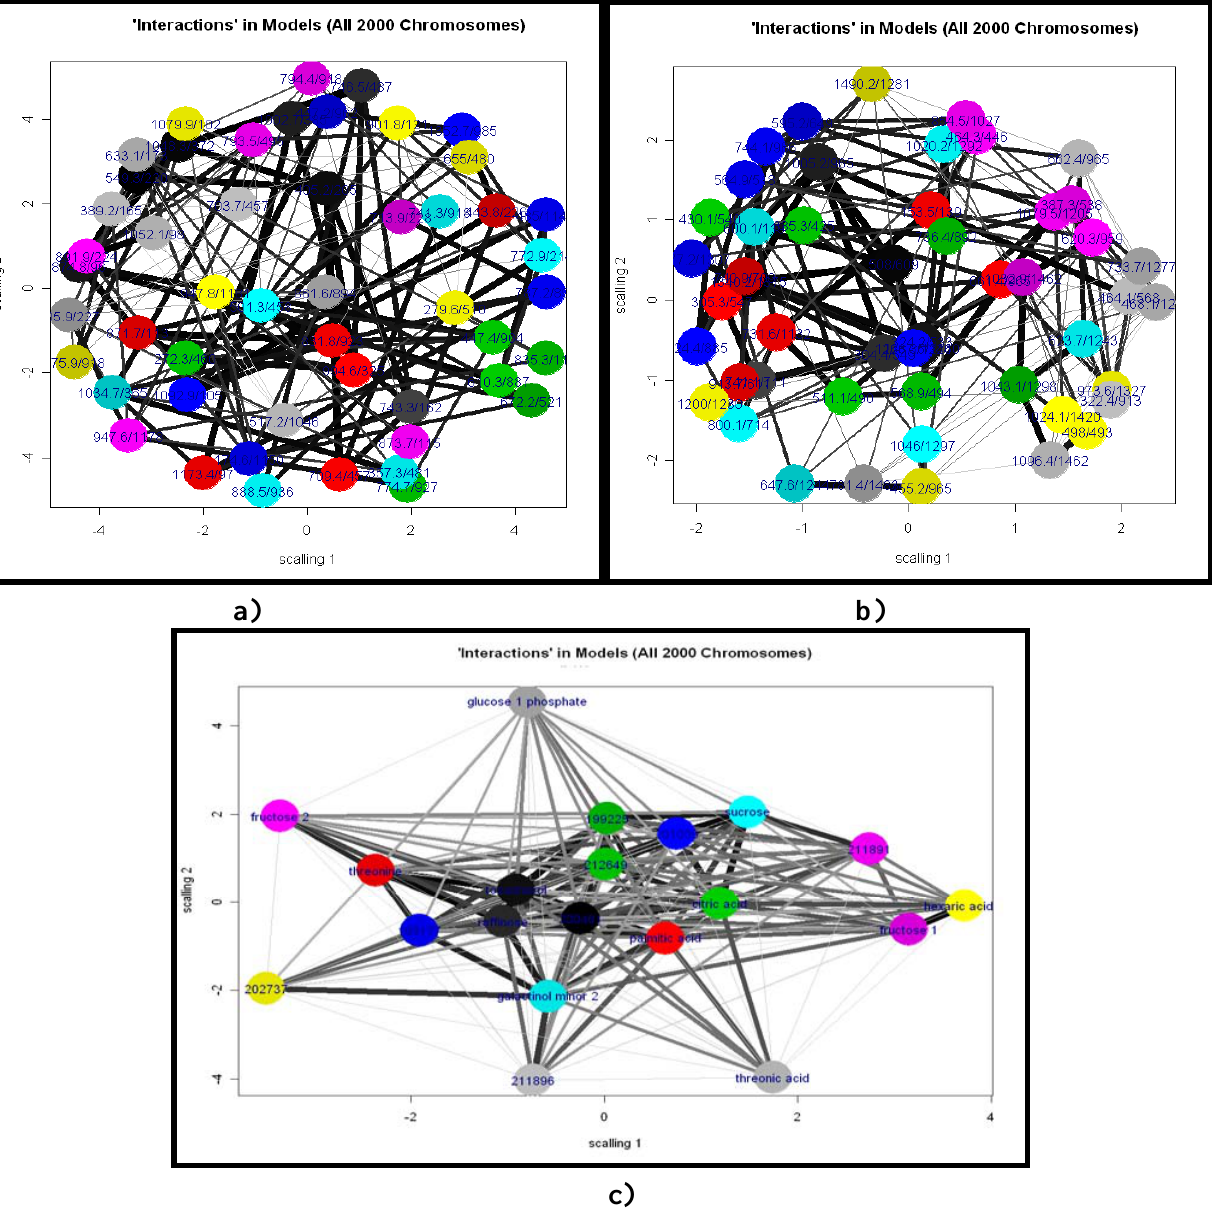
Figure 2a-c . Network interactions among feature components of the Pinus taeda L. HILIC ( a ), RP ( b ) LC–ESI–MS, and GC–TOF–MS ( c ) data. The line thickness represents the dependency strength relative to the population of relations shown. Top components were color-coded: the most frequent ones were black, then red, green, blue, cyan, pink, yellow, and gray. Predictors are described as mass to charge ratio which is unique characteristic of metabolite or chemical name for annotated